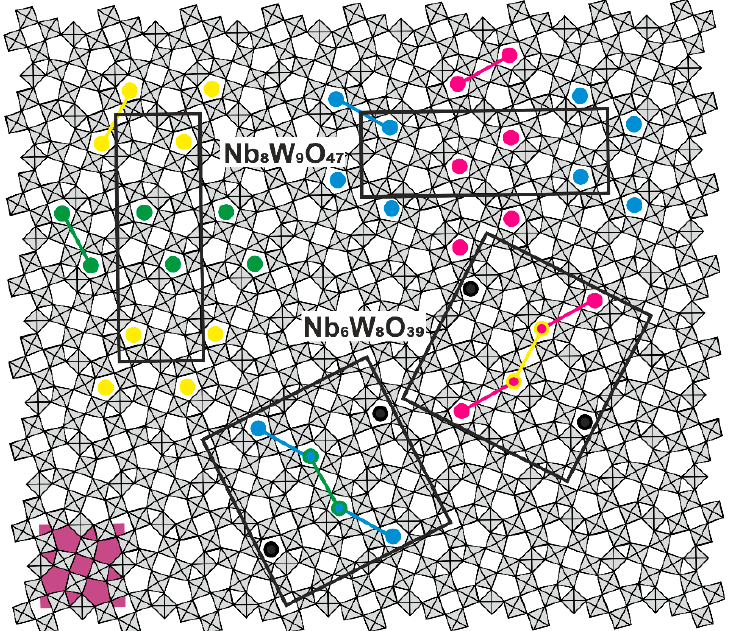
Figure 1. Structural models of Nb 8 W 9 O 47 and Nb 6 W 8 O 39 in projection along [001]. Two possible orientations of both structures are shown (unit cells are framed). Filled pentagonal tunnels (PTs) are represented by filled circles. Pairs of filled PTs (filled circles of same color) are connected via the diamond link (some marked by colored lines). A TTB subcell with composition M 10 O 30 (M = Nb,W) is colored purple.